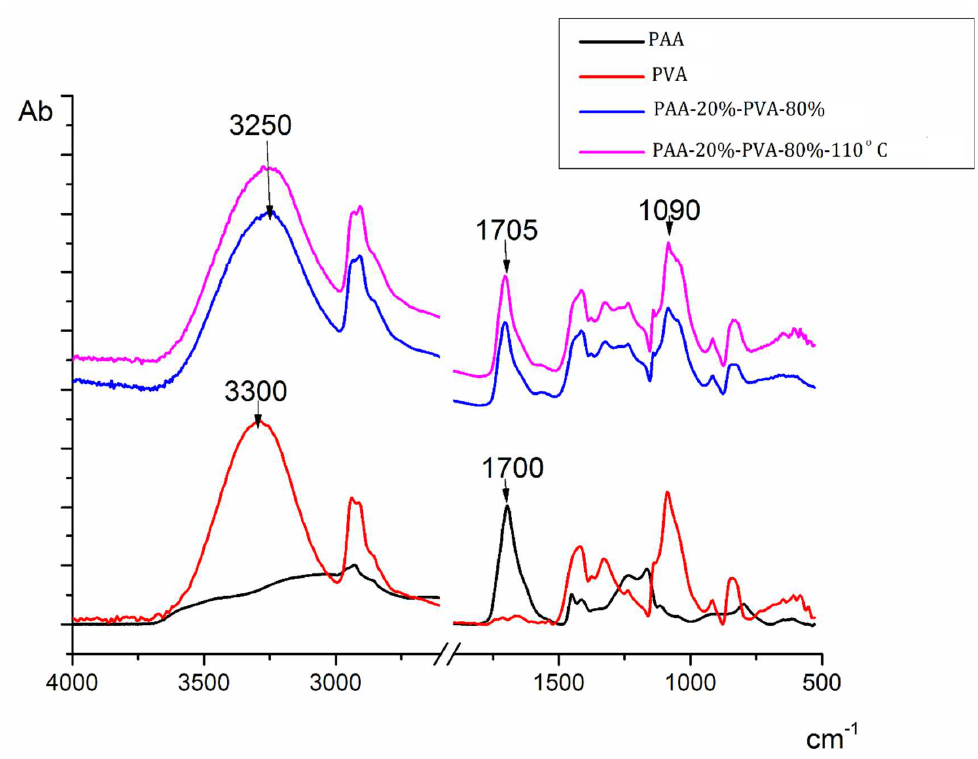
Figure 3. FTIR spectra of PVA-PAA samples.